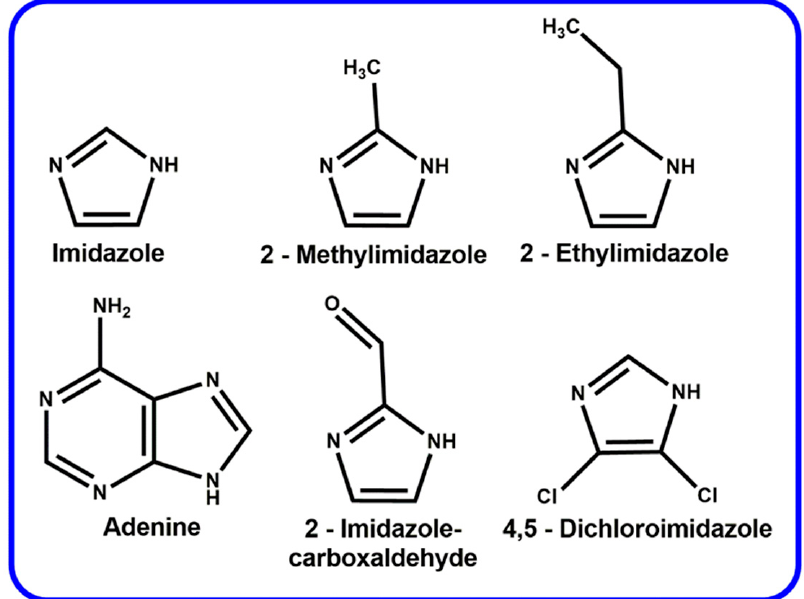
Figure 2. Examples of imidazolate-based ligands for the synthesis of Zeolitic imidazolate frame- works [32].